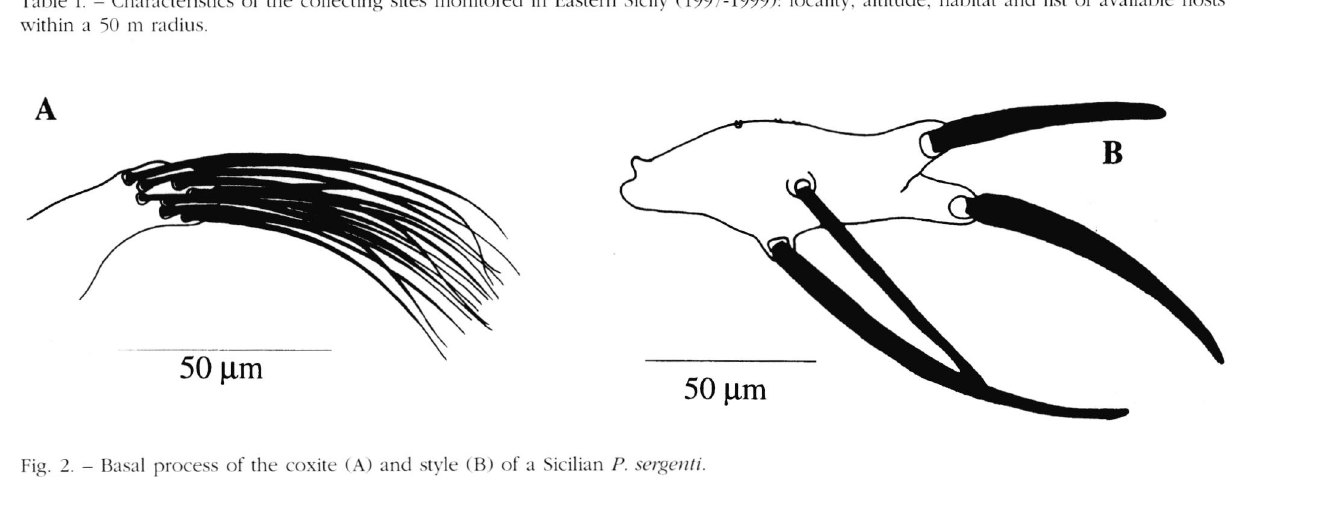
Fig. 2. - Basal process of the coxite (A) and style (B) of a Sicilian P. SERGENTI.